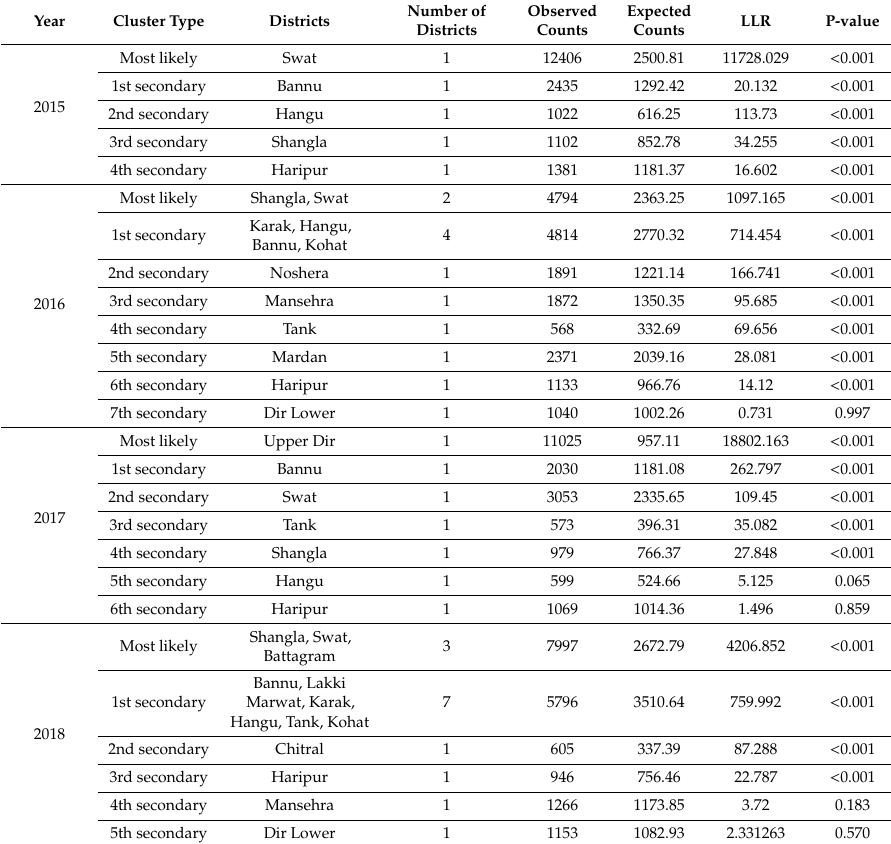
Table 2. The detected spatial clusters of TB cases in Khyber Pakhtunkhwa, Pakistan. Cluster Type